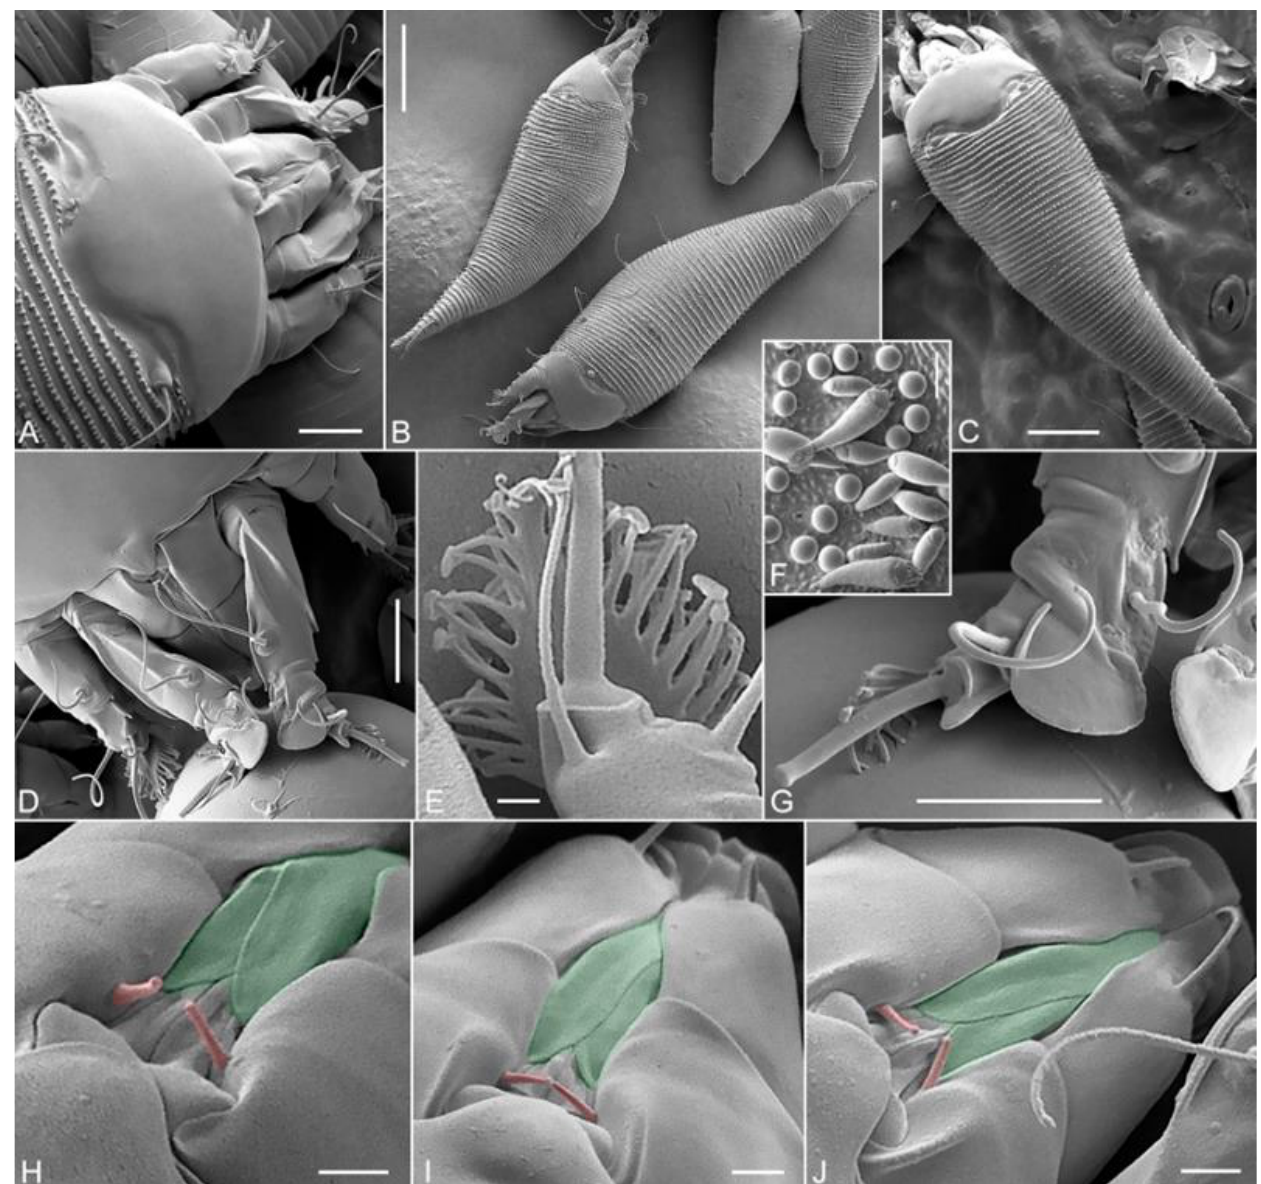
Figure 4. LTSEM images of morphotype A females (and partly shown immatures in backgrounds in A , B and in colony in F ) of Aberoptus schotiae n. sp. ( A )—dorsal view of anterior part of female; ( B )—entire lateral (upper) and semi-lateral (bottom) mites; ( C )—dorsal view of entire mite; ( D )—dorsal view of gnathosoma and legs; ( E )—dorsal view of apical part of tarsus II; ( F )—colony underneath removed web nest; ( G )—dorsal view of tibia and tarsus of leg I; ( H – J )—dorsal view of gnathosoma in three females, stylet sheath and palpcoxal setae ep are colored green and red respectively. Scale bars: ( A , D , G ) = 10 µm; ( B ) = 50 µm; ( C ) = 30 µm; ( F ) = 100 µm; ( E ) = 1 µm; ( H – J ) = 2 µm.